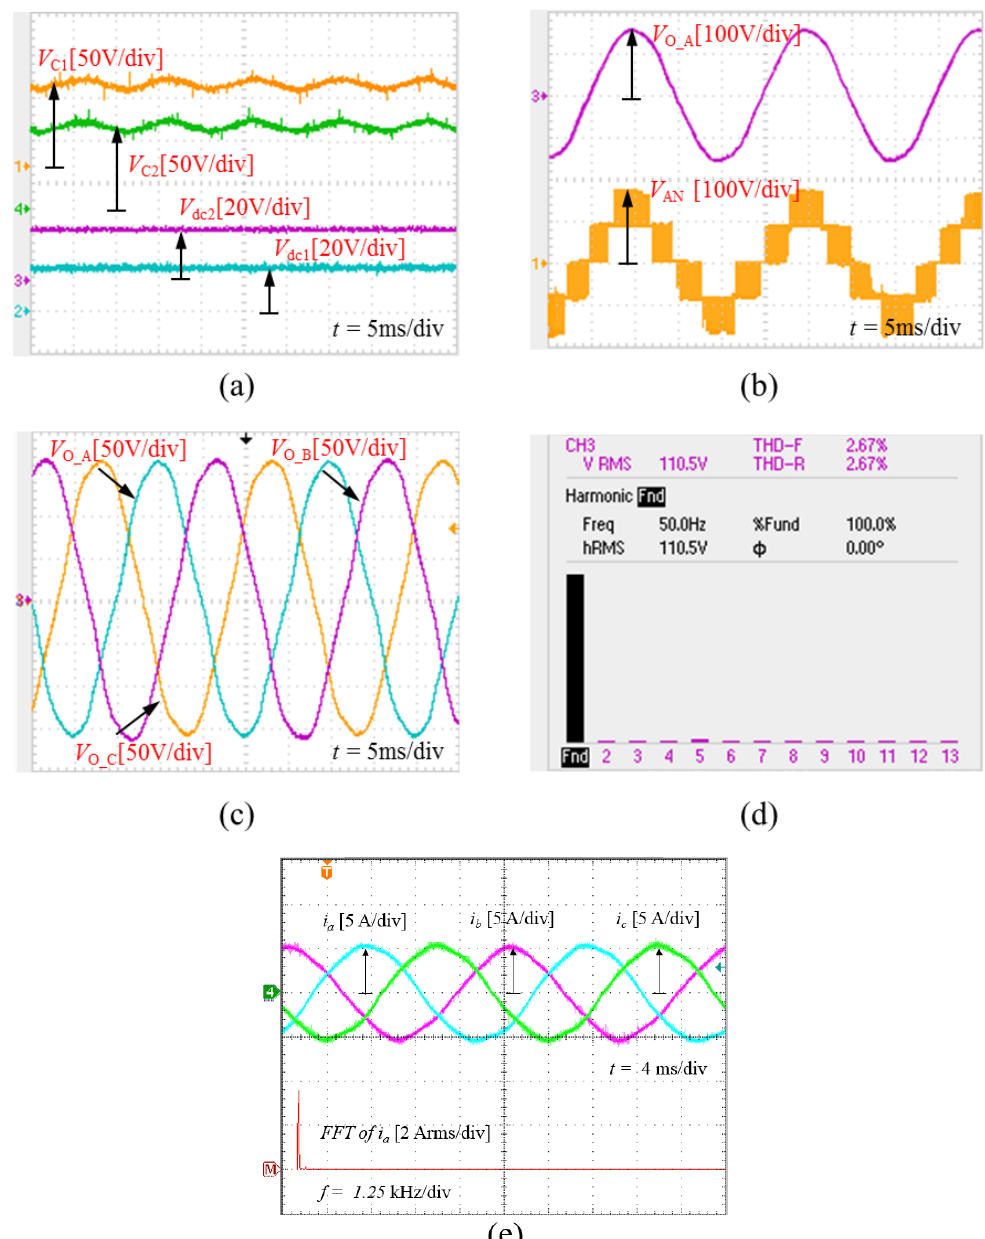
Figure 9. Experimental results for the suggested inverter with the unbalanced condition input voltage, V dc 1 = 20 V and V dc 2 = 25 V. ( a ) Input voltage and capacitor voltage in qSBI stages; ( b ) five-level output voltage before and after the filter of phase A (V AN ); ( c ) three-phase output voltage; ( d ) harmonic spectrum of output voltage, and ( e ) output currents and harmonic spectrum of output phase-A current.